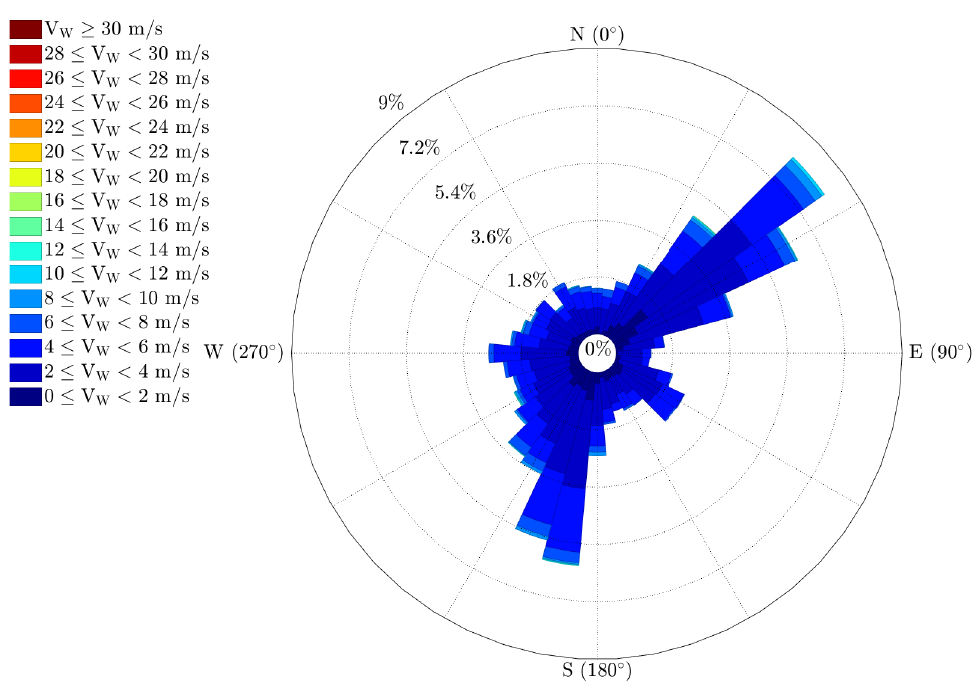
Figure 8. Wind rose diagram for all LLJ events observed at the Clausthal-Zellerfeld site at 40 m